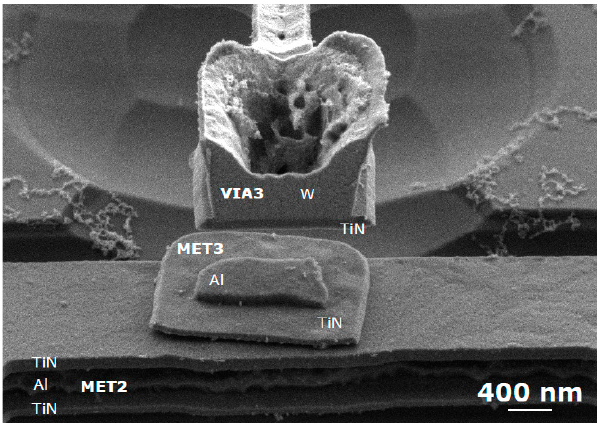
Figure 6. SEM image taken in the contact region of the seesaw relay showing the over-etch of the Al layer contained in the sandwiched MET3 layer of TiN-Al-TiN.